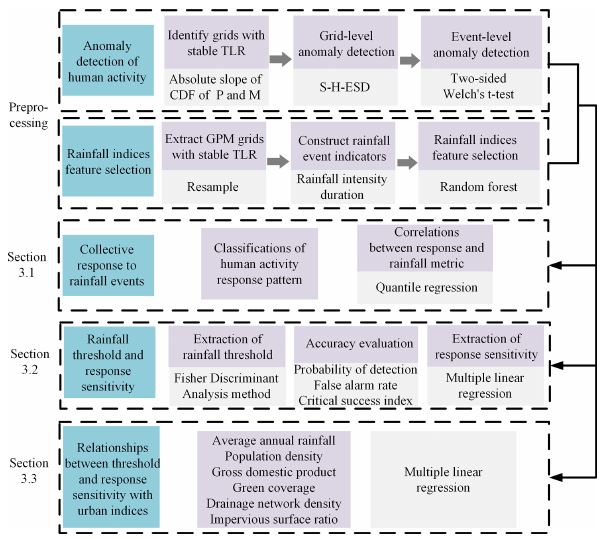
Figure 1. A flow chart showing the data analysis process in this study. S-H-ESD denotes seasonal hybrid extreme Studentized devi- ate.